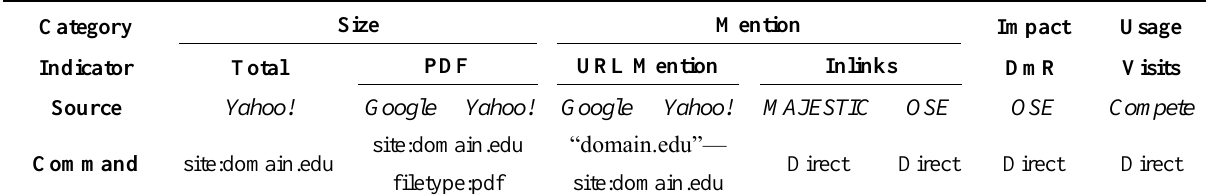
Table 1. Summary of categories, indicators, sources, and commands used for web measures. Category Size Mention Impact Usage Indicator Total PDF URL Mention Inlinks Source Yahoo! Google